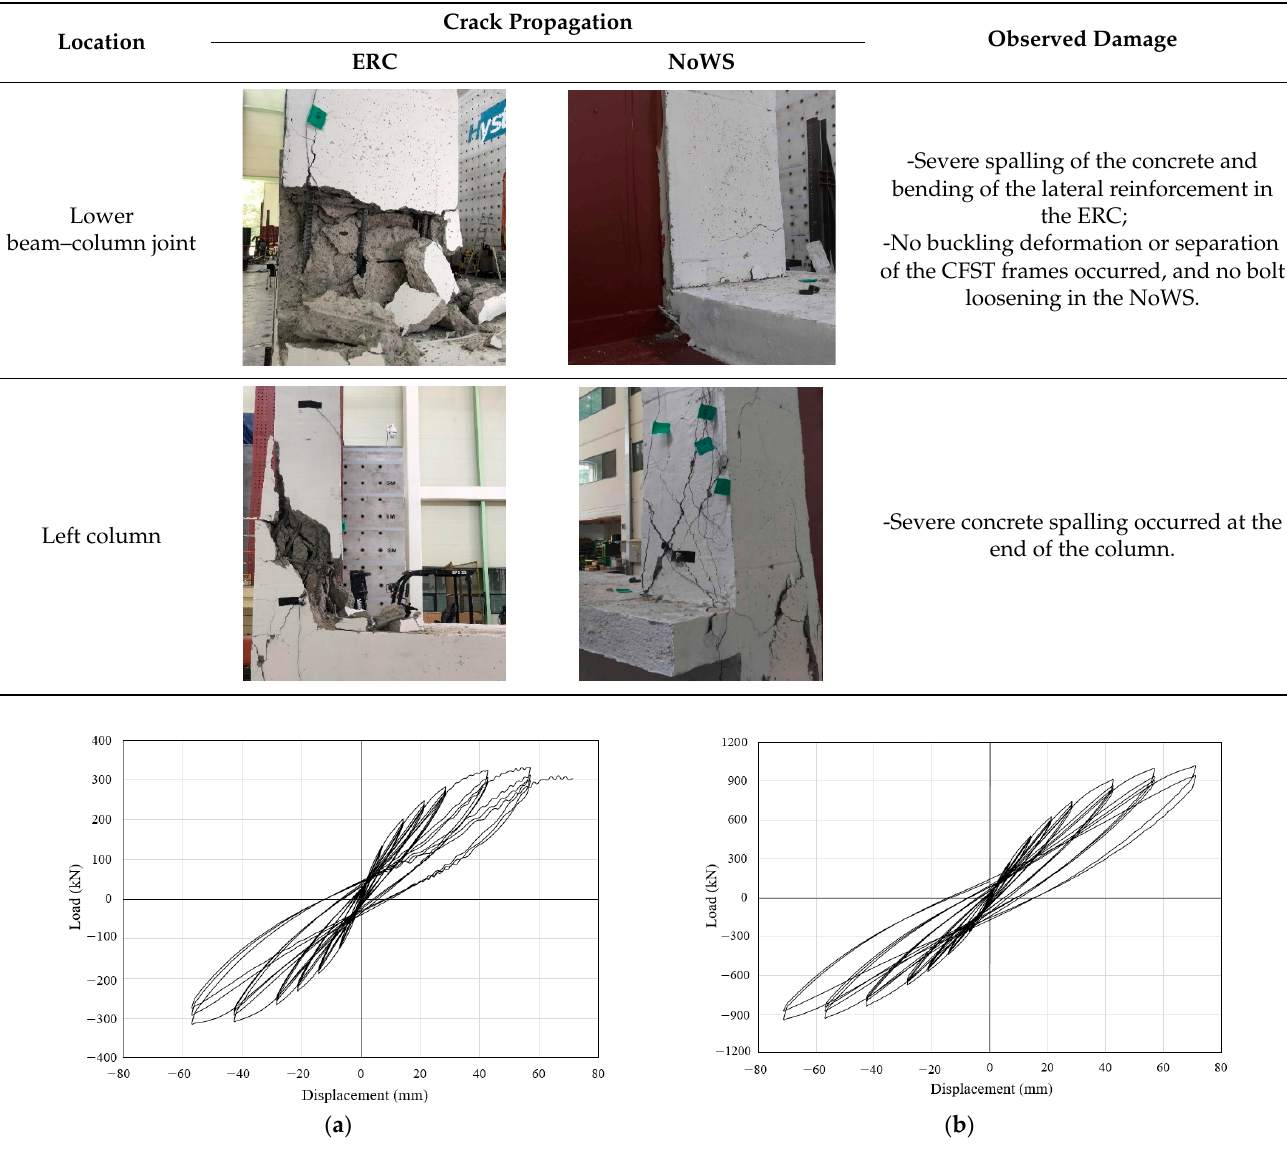
Figure 10. Load–displacement curves: ( a ) ERC; ( b ) NoWS.